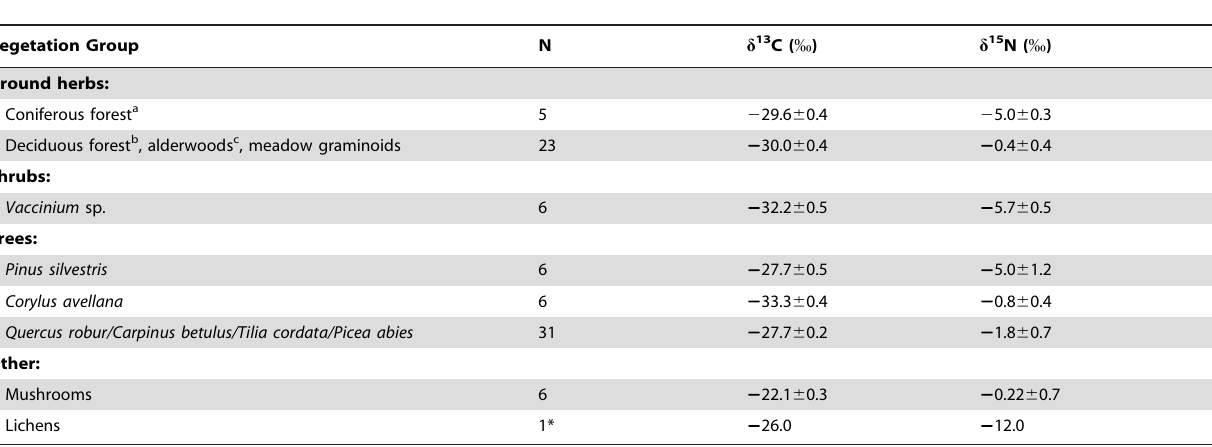
Table 1. Isotopically distinct vegetation groupings (mean 6 SE) used to examine dietary niches of the two rodent species in Białowiez _ a